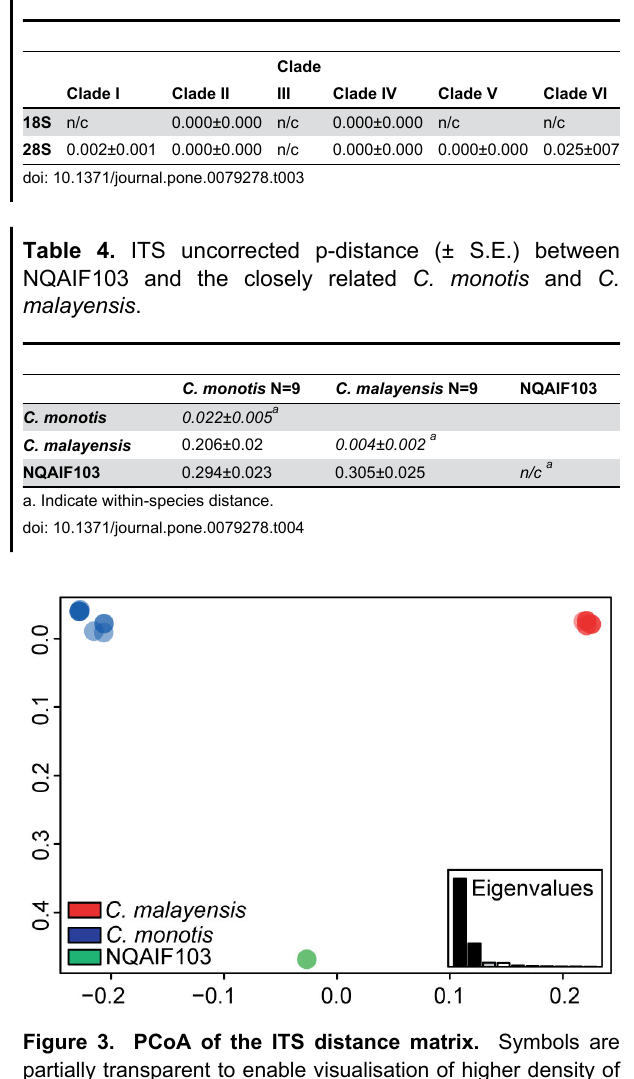
Table 3. Within clade uncorrected p-distances (± S.E.) .